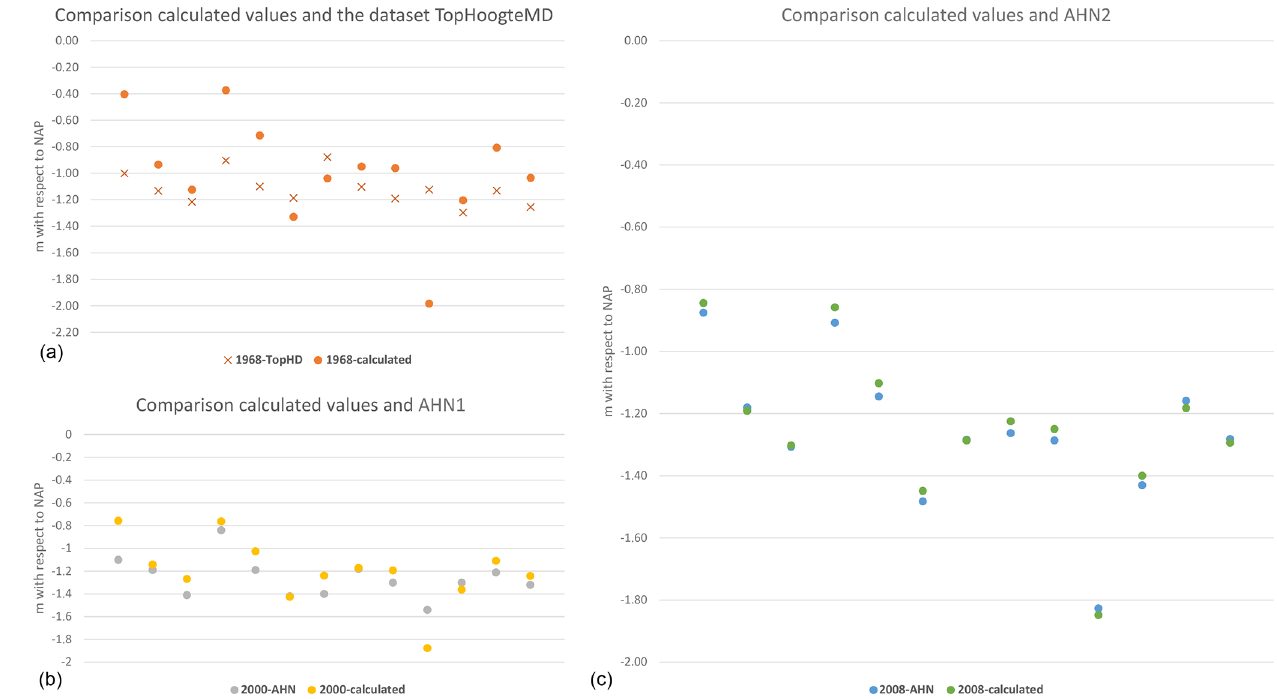
Figure 3. Deviation of the model from measured surface levels with Tophoogte (a) , AHN1 (b) and AHN 2 (c)